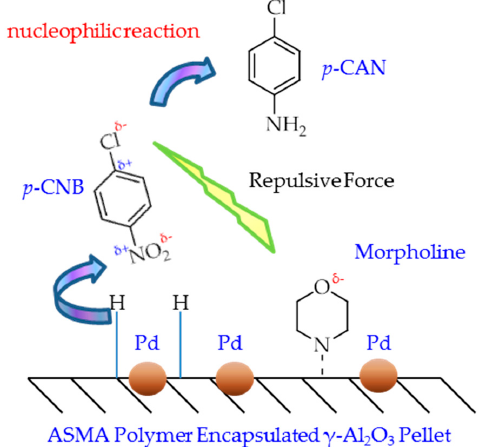
Figure 12. Scheme showing the principle of the catalyst composed of Pd ‐ modified, ASMA polymer ‐ encapsulated γ ‐ Al 2 O 3 pellet and the process of hydrogenation of p ‐ CNB to p ‐ chloroaniline ( p ‐ CAN).